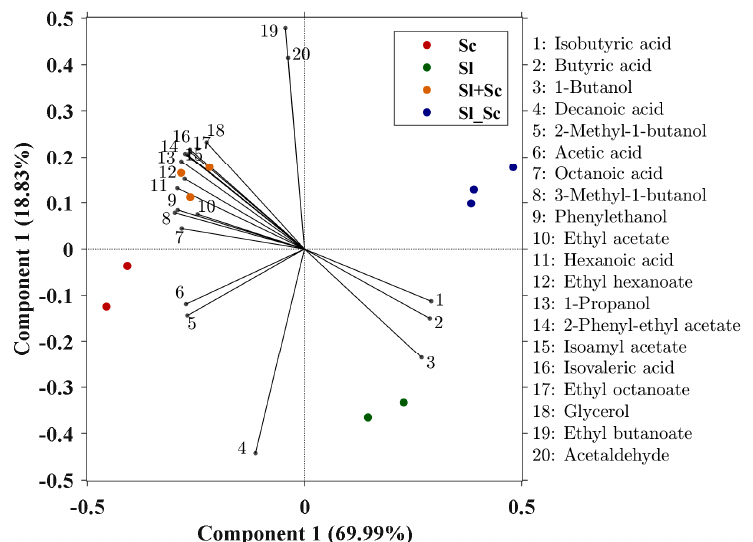
Figure 2. Partial least squares-discriminant analysis (PLS–DA) plot of wines obtained with the different inoculation strategies using volatile and non-volatile compounds that were significantly different among treatments—single-culture of S. ludwigii UTAD17(Sl) and S. cerevisiae (Sc) or in consortium—mixed simultaneously (Sl+Sc) and sequentially (Sl_Sc).